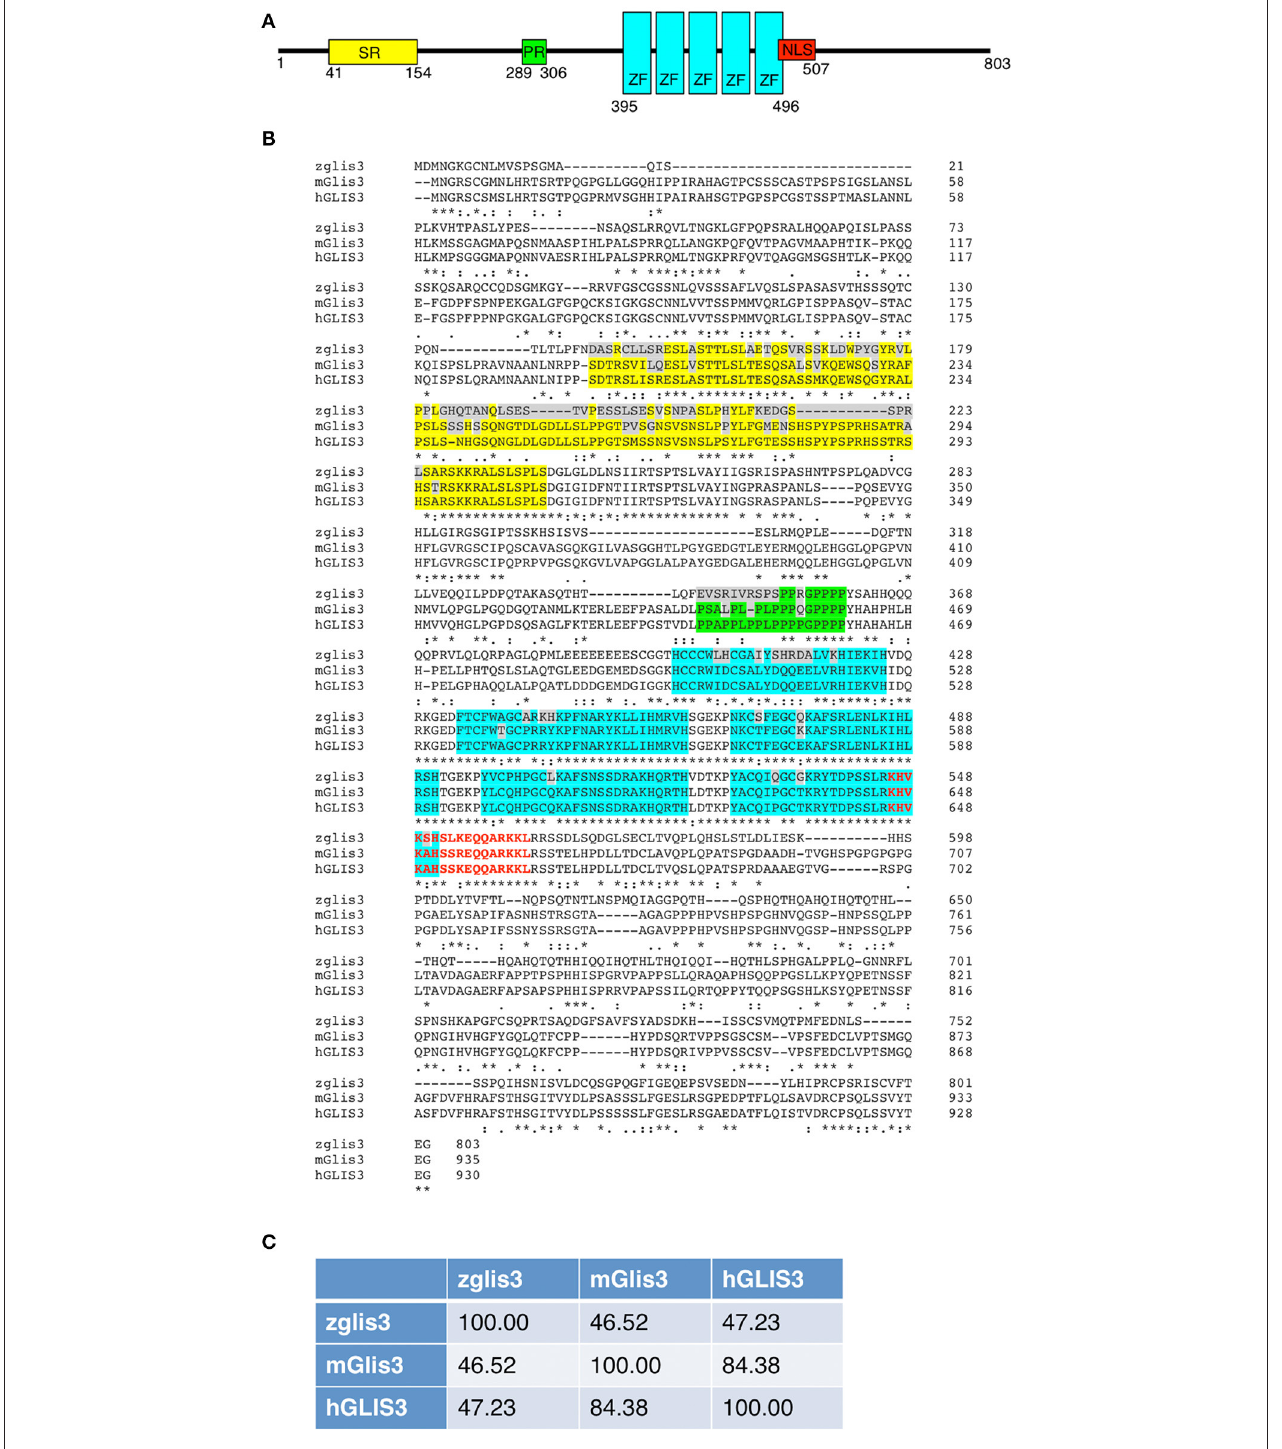
FIGURE 1 | (A) Schematic representation of the zebrafish glis3 protein (UniProt F1QB13). Yellow, Serine-Rich (SR) domain; Green, Proline-Rich (PR) domain; Light Blue, Zinc-Finger (ZF) domain; Red, Nuclear Localization Signal (NLS). (B) Alignment of the GLIS3 protein sequencing of the zebrafish (UniProt F1QB13), mouse (UniProt Q0GE24), and human (UniProt Q8NEA6). The color code of the different domains is reported above. The residues that differ between species are highlighted in gray. The missense GLIS3 variants identified in NDH (orange) and CH (green) patients are reported. (C) Aminoacid identity between zebrafish, murine and human GLIS3 proteins, performed using ClustalW2 software.